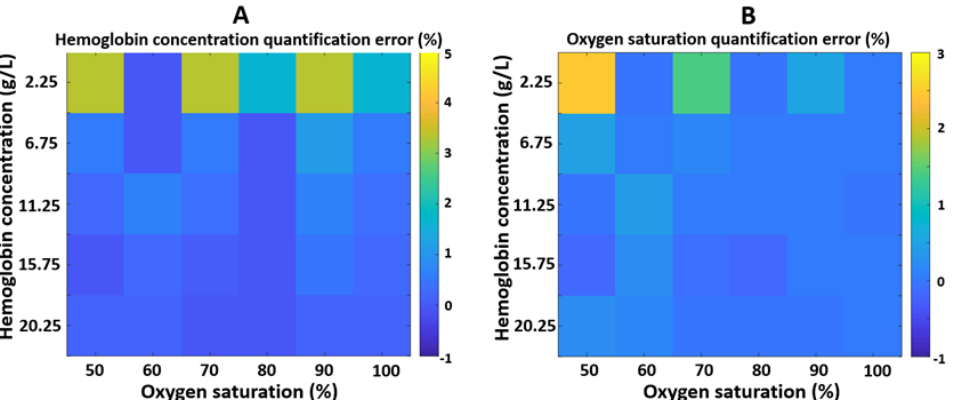
Figure 6. Relative quantification error of ( A ) total hemoglobin concentration and ( B ) oxygen satura- tion between the designed values and the values obtained with the stage-2 LUT.